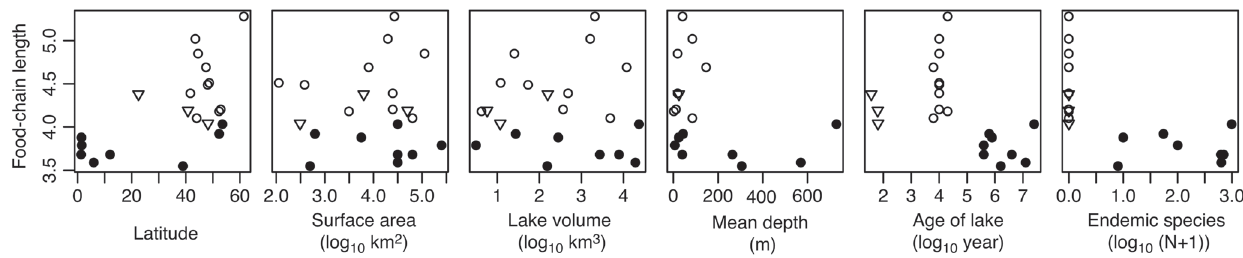
Figure 2. Correlations between food-chain length, latitude, log 10 surface area (km 2 ), log 10 volume (km 3 ), mean depth (m), log 10 age of lake (year, the points of Lake Kyoga and Victoria were plotted as 400,000 year), and log 10 (endemic species number + 1). Symbols mean the origin of lakes as Fig.1A.